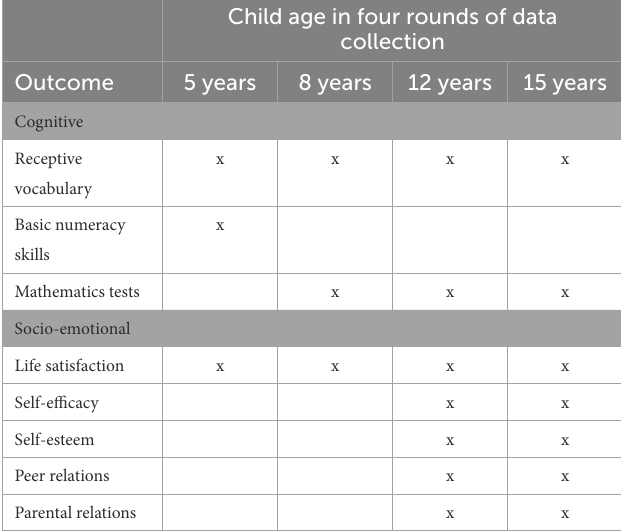
TABLE 5 Internal consistency of the self-concept and relationship measures when Vietnamese children were 12 and 15 years of age.